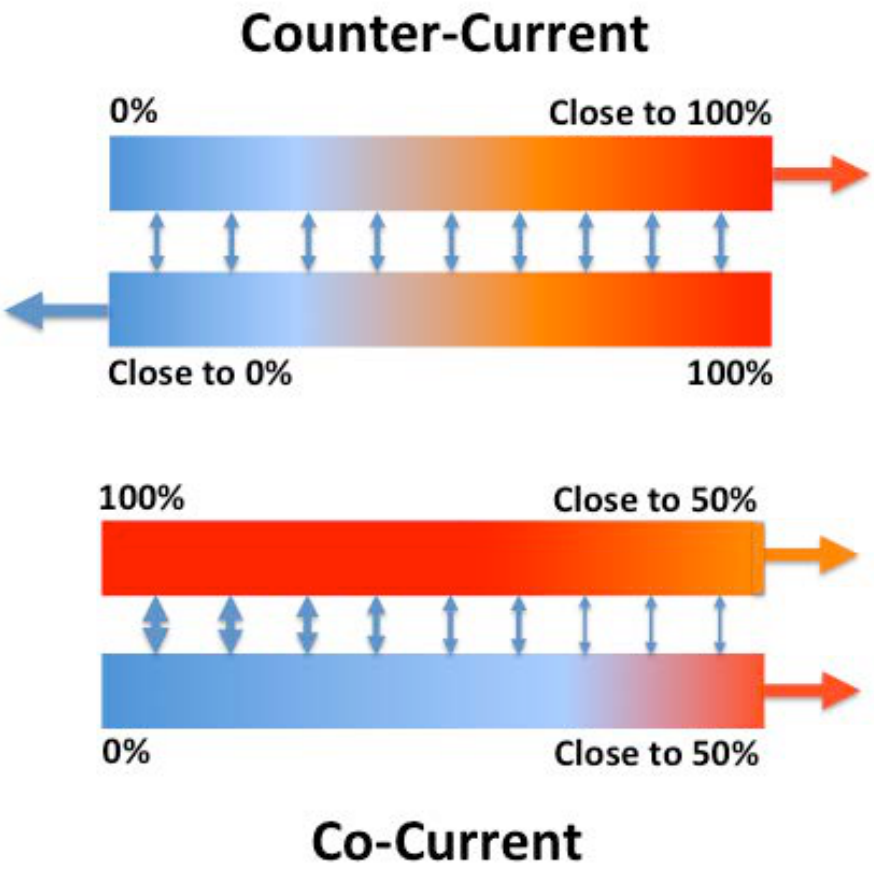
Figure 13. Size and Technology vs. Heat Exchange Comparison. Diagrams show that for the same size and technology level, the heat exchange is less than 50% for the co-current